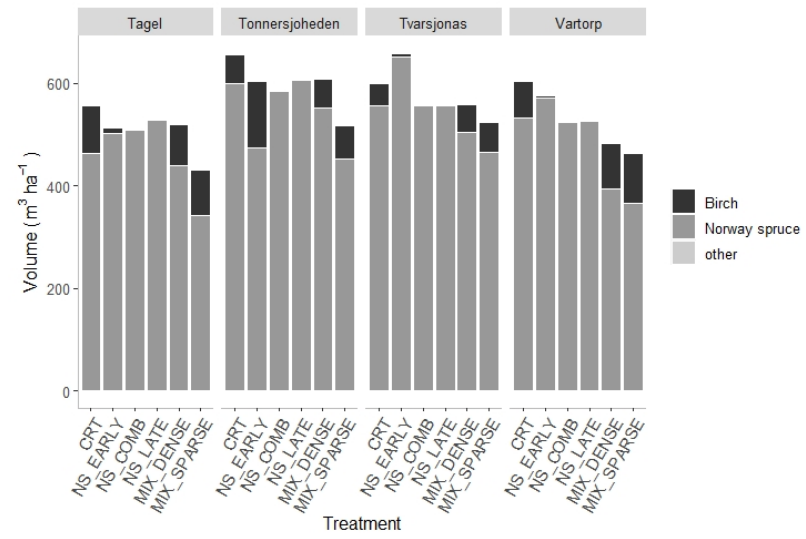
Figure 3. Standing volume of stands during final felling across multiple sites with different PCT strategies. The treatments were: control (CTR), early PCT (NS_EARLY), early and late PCT (NS_COMB), late PCT (NS_LATE), mixed sparse (MIX_SPARSE), and mixed dense (MIX_DENSE).